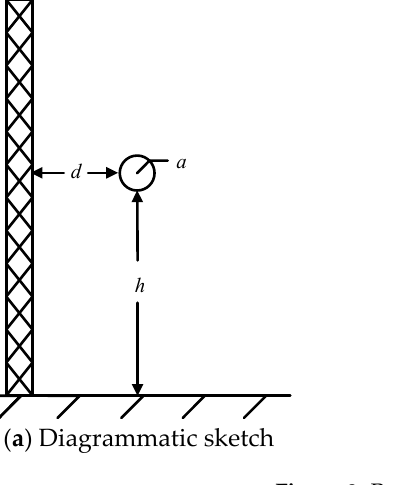
Figure 3. Research on line height.